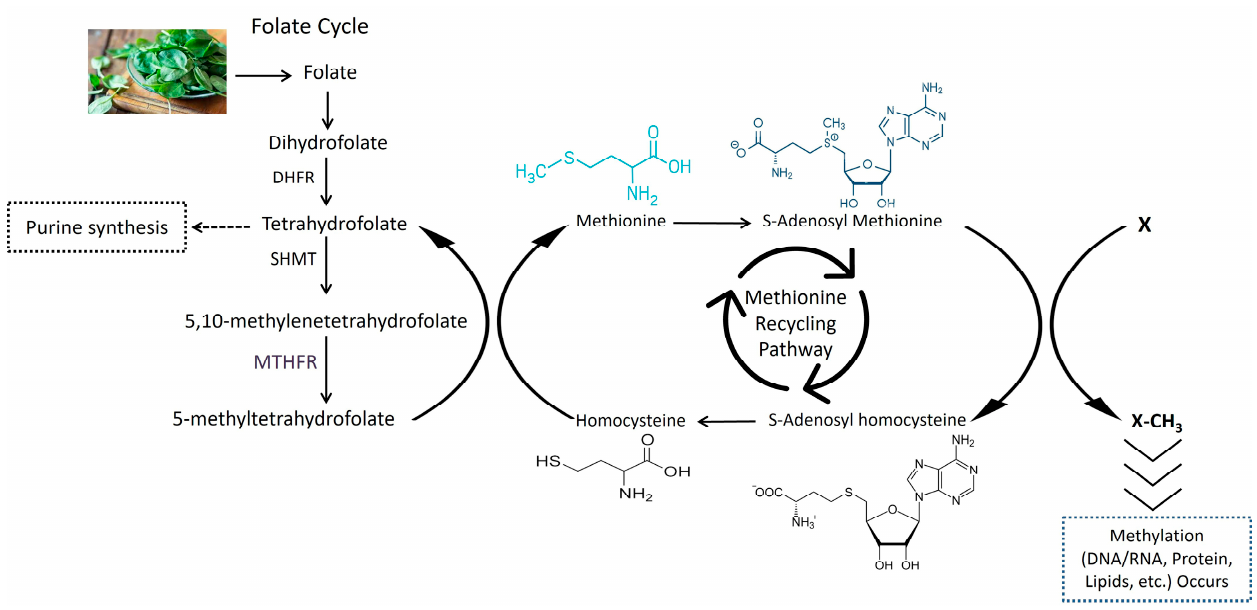
Figure 1. Mechanism of methylene tetrahydrofolate reductase (MTHFR) in folate and homocysteine metabolism.